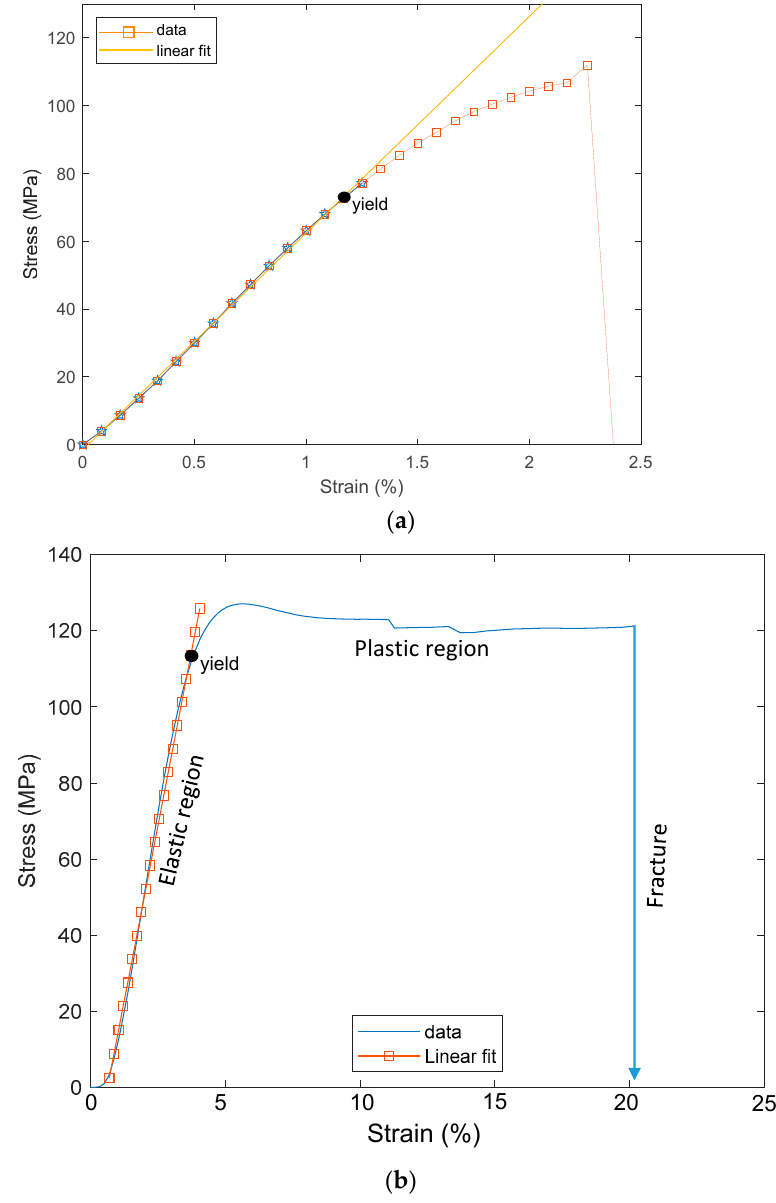
Figure 6. Stress-strain curves of PSPI test samples. ( a ) Thickness = 5 µm. ( b ) Thickness = 25 µm.